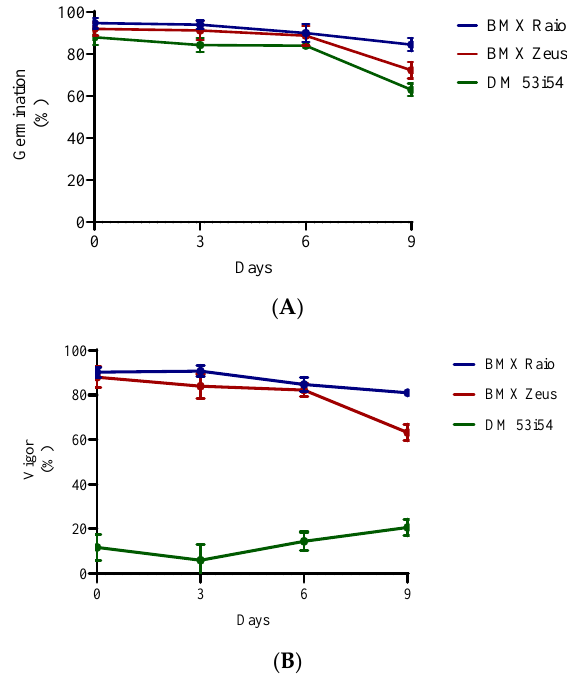
Figure 1. Germination ( A ) and vigor ( B ) of three cultivars (BMX Raio, BMX Zeus, and DM 53i54) exposed to different periods of accelerated aging (0, 3, 6, and 9